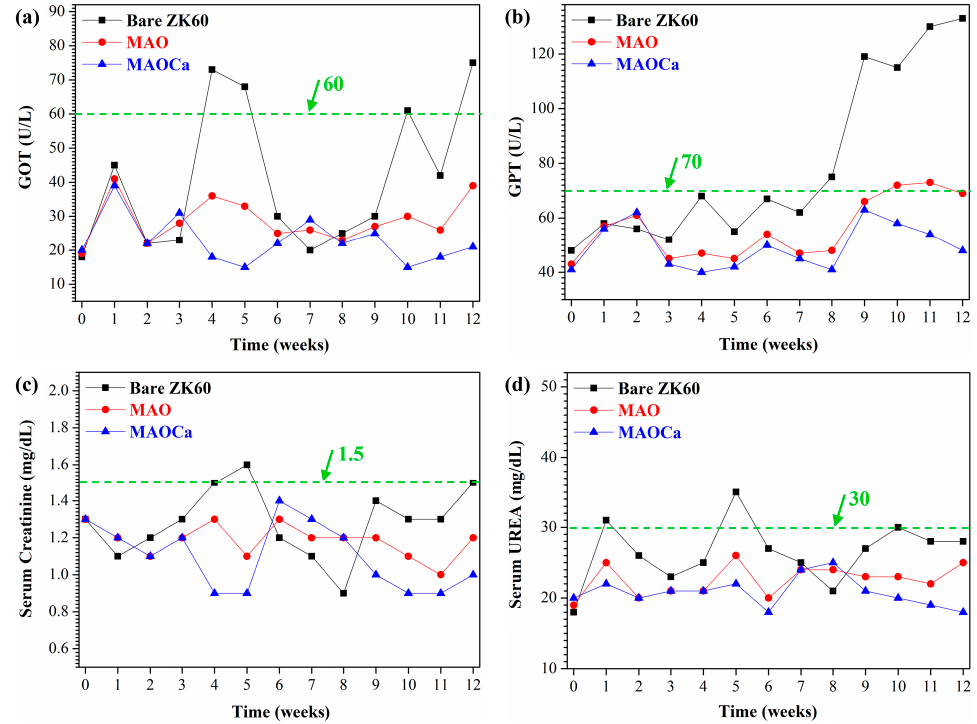
Figure 15. Blood test results for implants of the untreated, MAO-treated and MAOCa-treated ZK60 bone screws 12 weeks after implantation: ( a ) GOT, ( b ) GPT, ( c ) serum creatinine, and ( d ) serum urea.